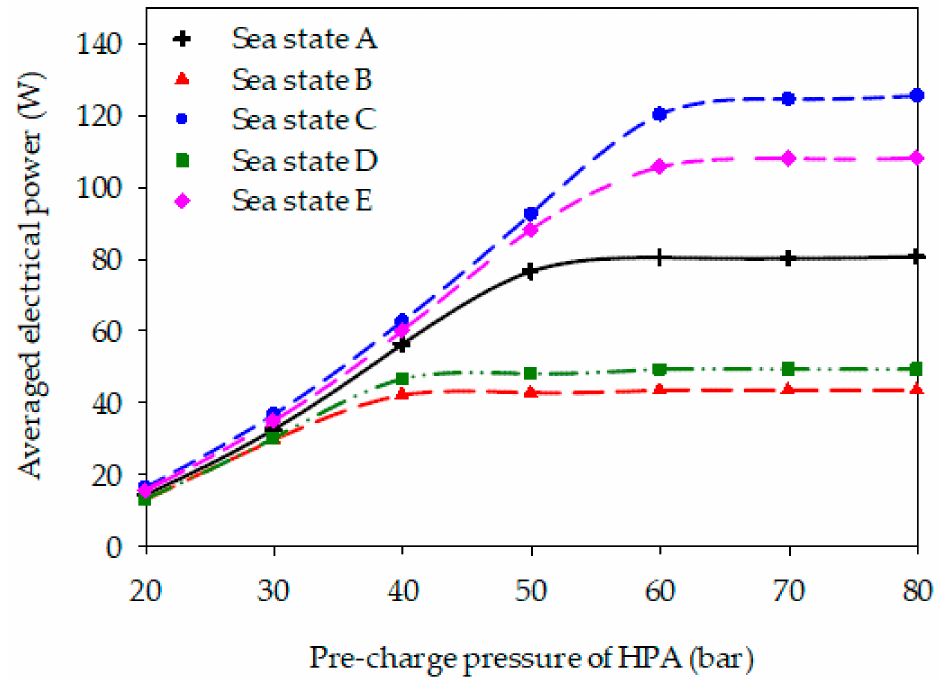
Figure 11. Averaged power of generator versus pre-charge pressure of HPA corresponding to different sea